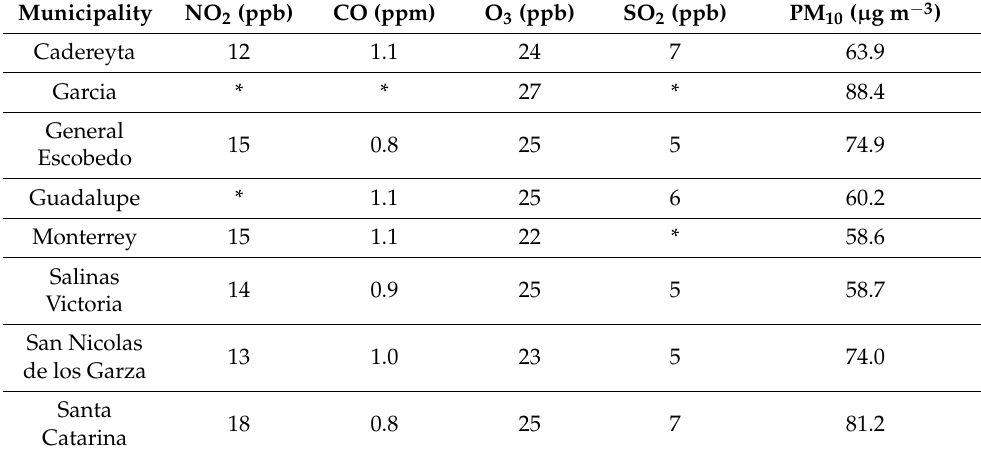
Table 3. Mean concentrations for air pollutant criteria in each municipality from 1 January 2016 to 31 December